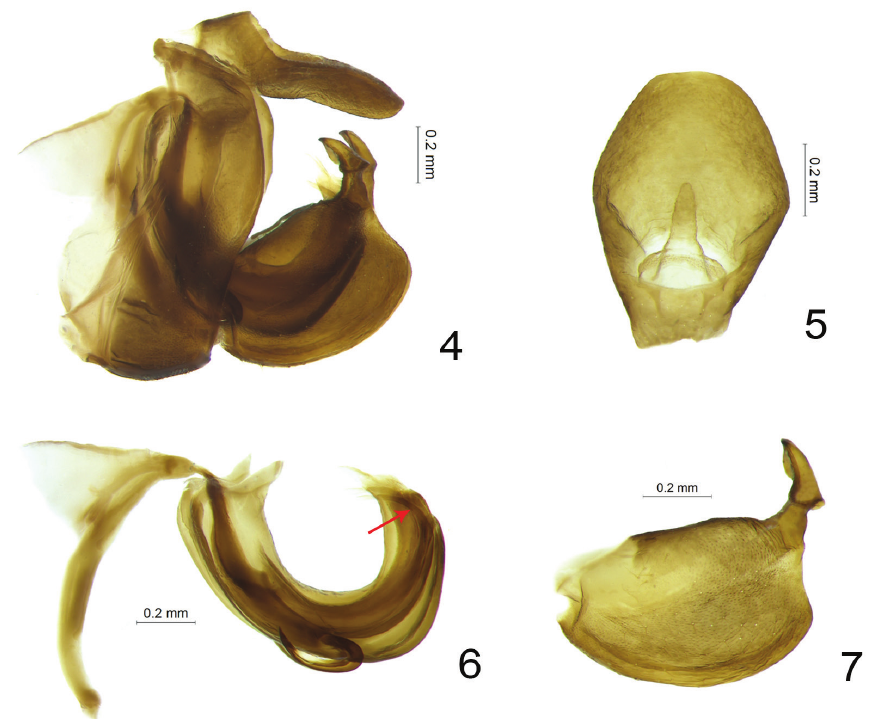
Figures 4–7. Sinonissus brunetus sp. n., holotype. 4 Male terminalia, lateral view 5 Male anal tube, dorsal view 6 Phallic complex, lateral view 7 Gonostylus, lateral view. The red arrow indicates the paired digitate processes on the dorsolateral lobe of